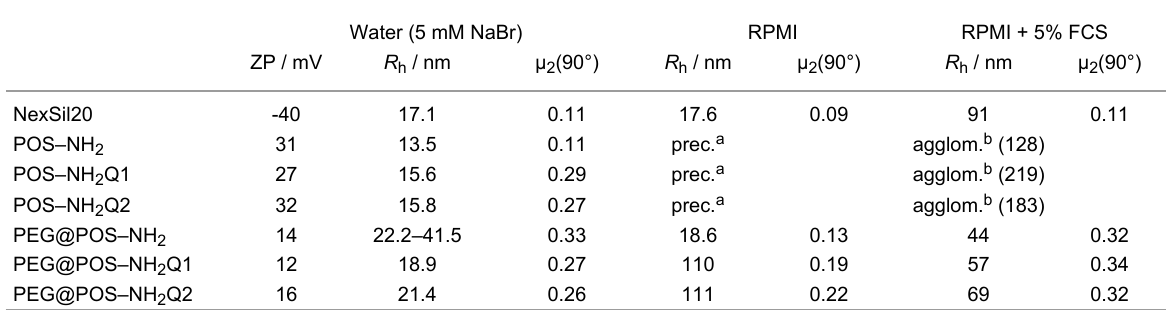
Table 1: Hydrodynamic radius, R h , and μ 2 values in different media for the samples discussed in this publication. NexSil20 NPs are commercial silica nanoparticles, POS-NH 2 NPs are amine-modified poly(organosiloxane) particles at different modification stages: bare, quaternized, PEGylated and PEGylated + quaternized. DLS measurements were performed with an ALV multiangle setup, all samples were filtered after mixing of the compo- nents, and radii were determined either by applying a biexponential fitting function (non-agglomerated samples) or by conducting a multicomponent analysis in the cases where proteins were present [28]. DLS analysis of the pure protein mixture in RPMI cell culture medium (RPMI + 5% FCS) yields